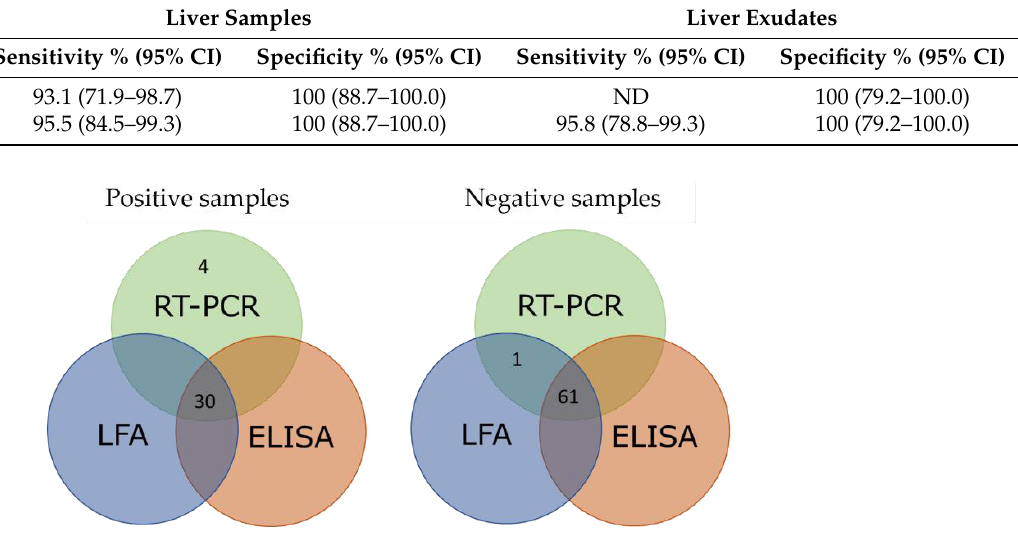
Table 2. Diagnostic performance of the developed assay compared to RT-PCR.